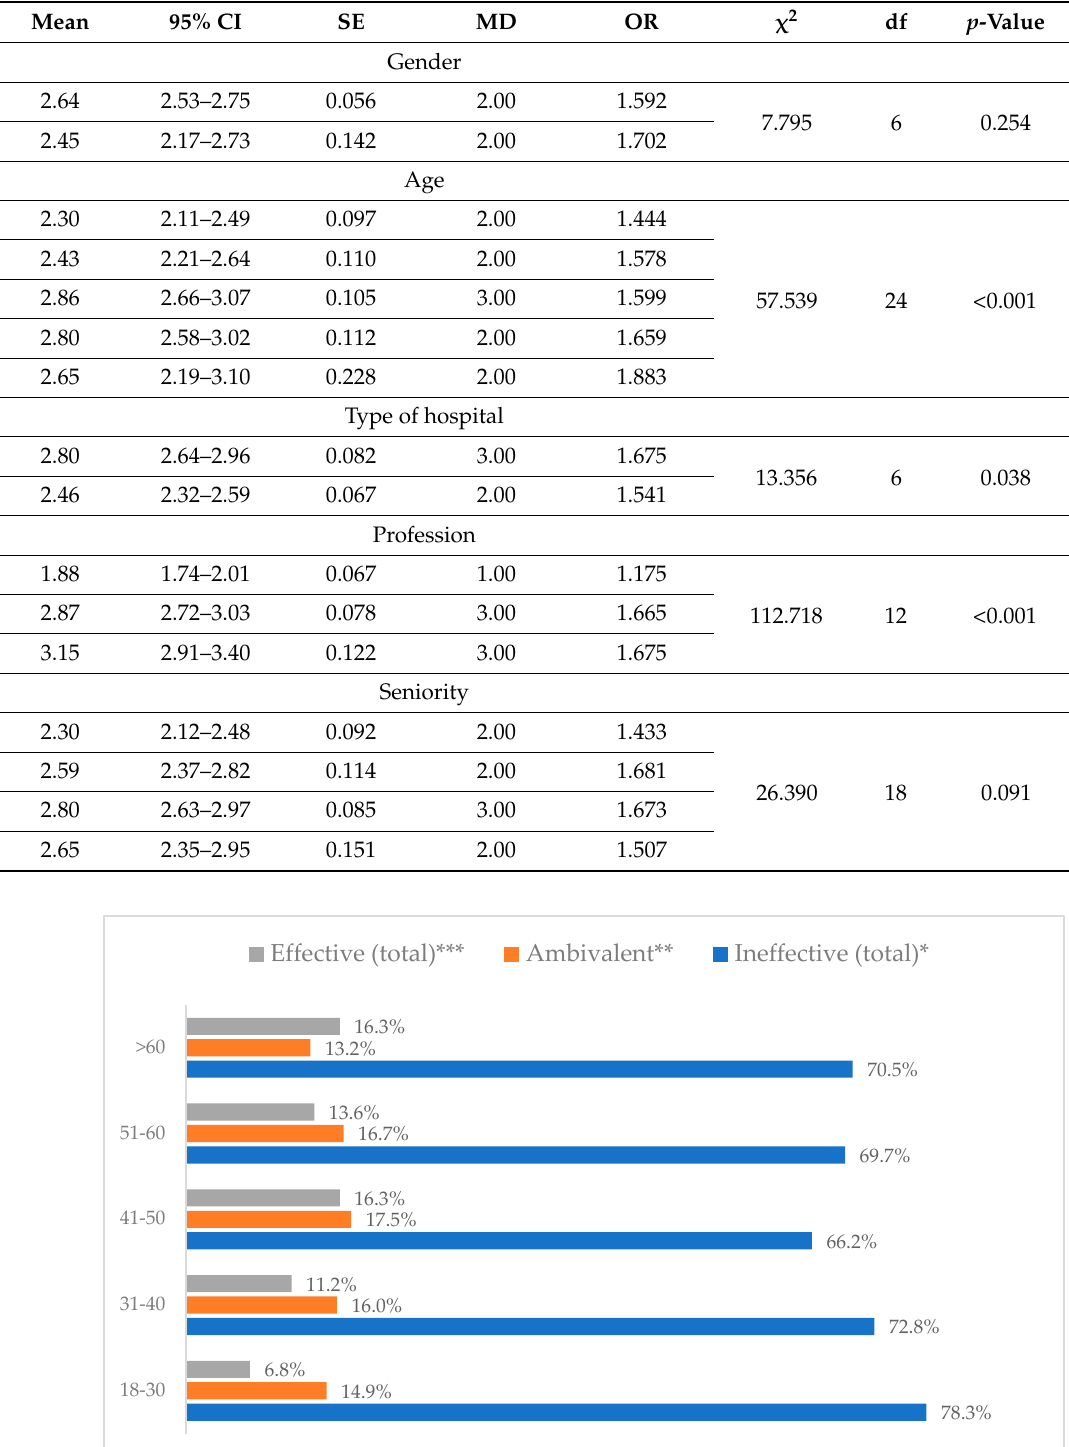
Figure 27. Taking preparations with inosine to prevent influenza virus infection by age ( N = 905). *Sum of responses: completely ineffective, ineffective, rather ineffective; **Response: neither inef- fective nor effective; ***Sum of responses: rather effective, effective, completely effective.